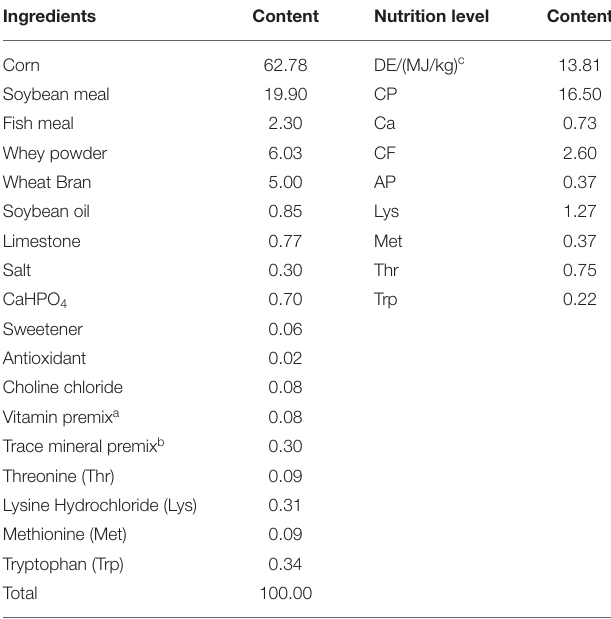
TABLE 1 | The ingredients and nutritional levels of basal diets (DM basis,